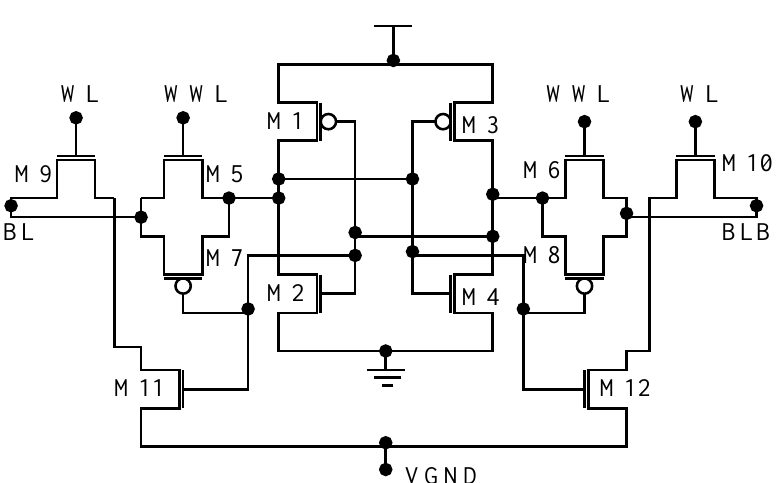
Figure 3. Proposed read stability and write performance aware 12T SRAM cell (RSWA12T).